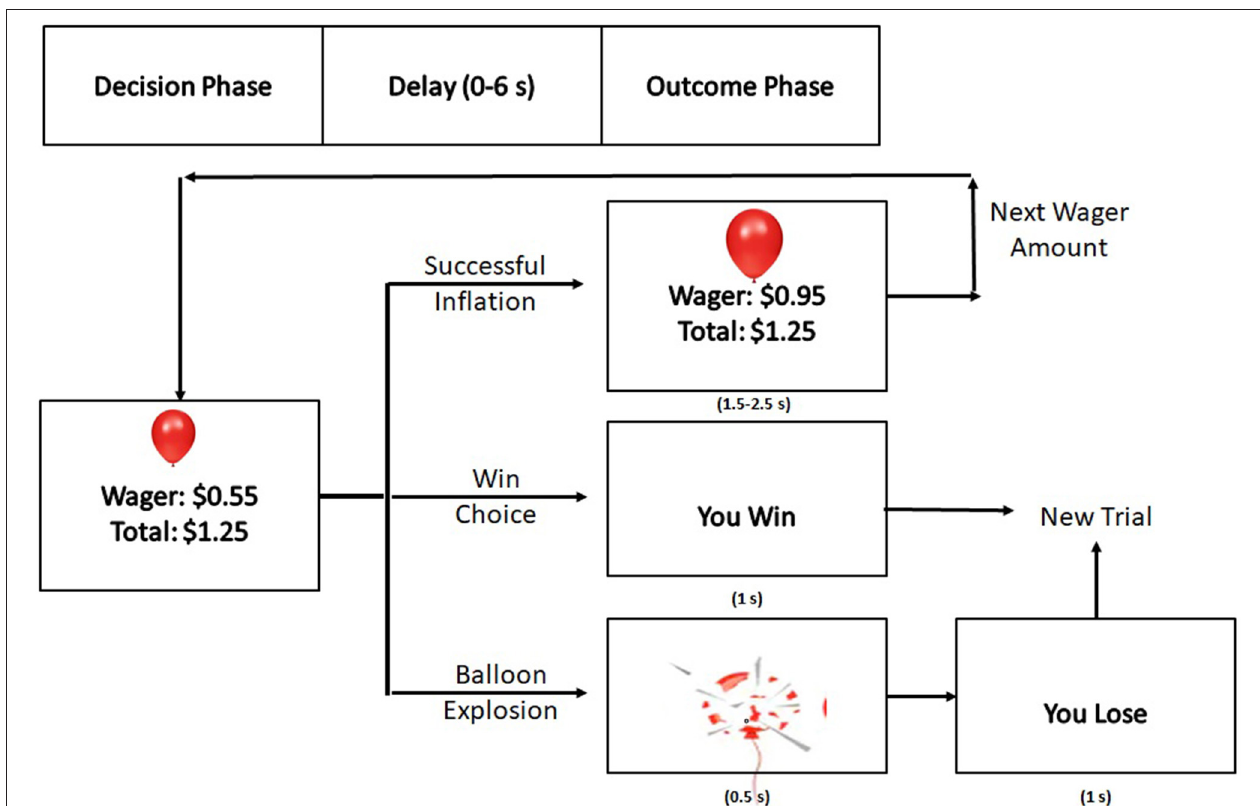
FIGURE 1 | A Depiction of the typical trial in the BART task.